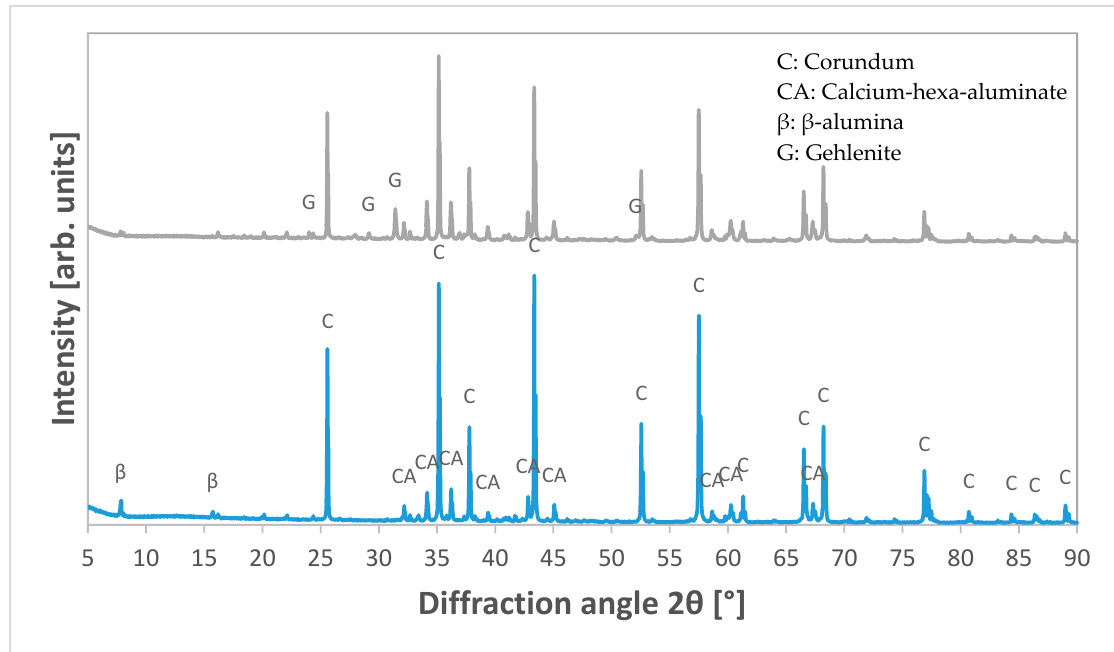
Figure 7. X-ray diffraction (XRD)-plot of the reference LCC (bottom) and the LCC after corrosion with Figure 7. X-ray di ff raction (XRD)-plot of the reference LCC ( bottom ) and the LCC after corrosion with blast furnace slag (top) showing gehlenite as the main reaction product. blast furnace slag ( top ) showing gehlenite as the main reaction